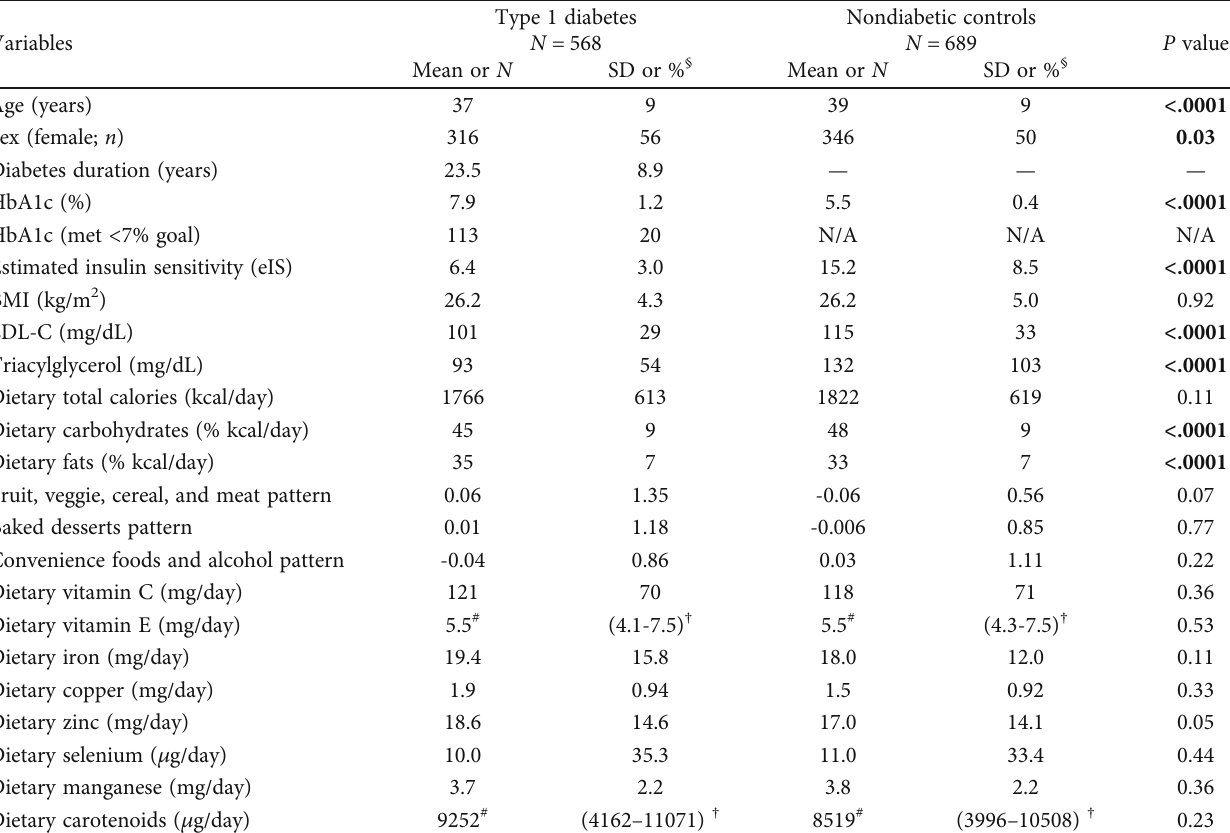
Table 1: Baseline characteristics of